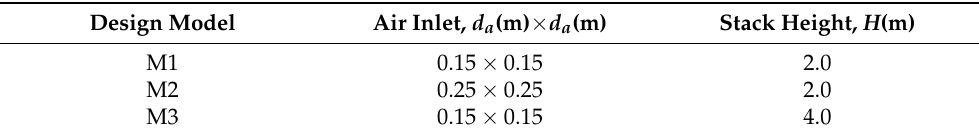
Figure 2. ( a ) Schematic of the VOC burner; ( b ) computational grid system for the VOC burner. Table 1. Combustor